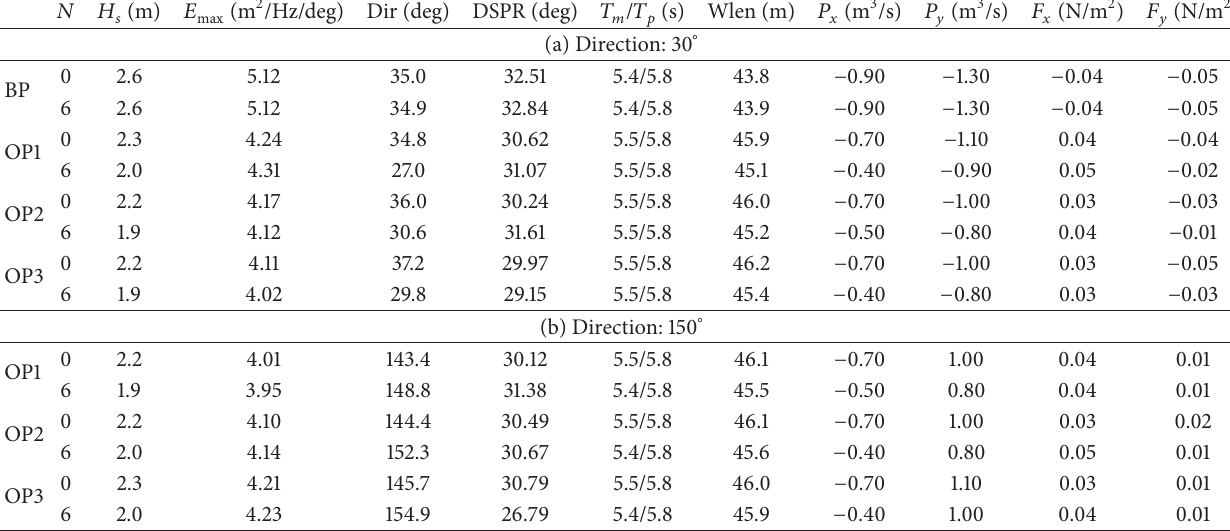
Table 5: Evaluation of the impact of the energy farms on the waves in the reference points OP1, OP2, and OP3 for the wave conditions (a) ∘ and (b) 𝐻 ∘ . 𝑇 𝑇 𝐻 𝑠 = 3m, 𝑚 = 6 s, and Dir = 30 𝑠 = 3m, 𝑚 = 6s, and Dir = 150